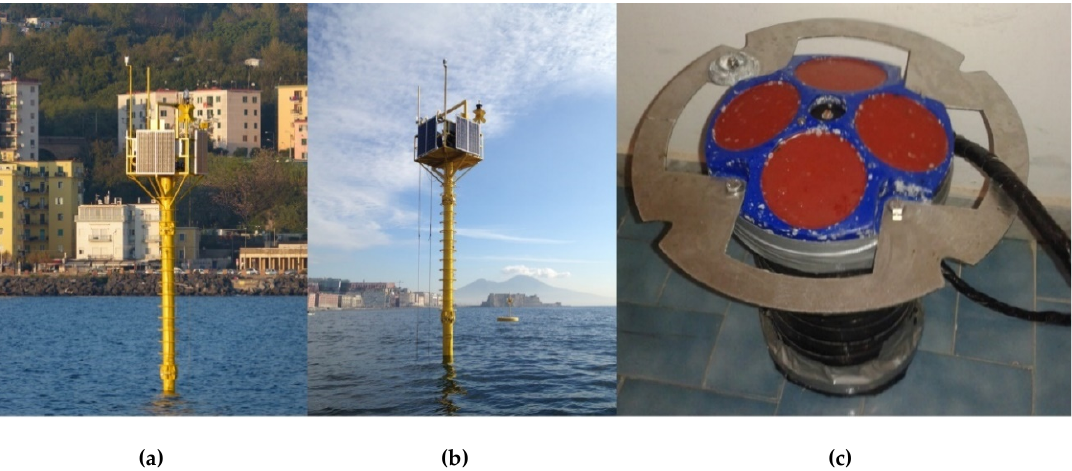
Figure 6. Stazione Zoologica “Anton Dohrn” (SZN) instruments: ( a ) MEDA A; ( b ) MEDA B; ( c ) acoustic Doppler current profilers (ADCPs). Table 6. ADCP configuration.